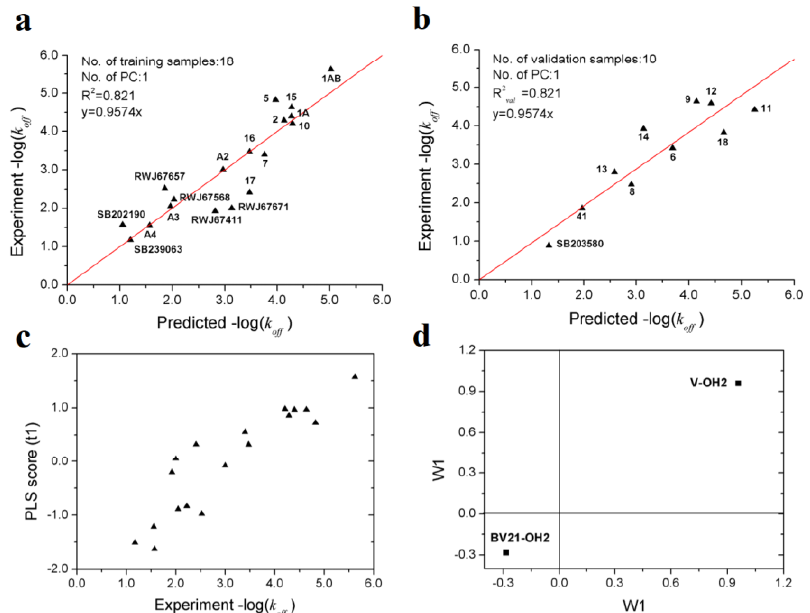
Figure 7. Optimal PLS model of the dissociation rate constants of 28 p38 MAPK inhibitors. ( a ) scatter plot of experimental vs. predicted −log( k off ) of the 18 training samples; ( b ) scatter plot of experimental vs. predicted −log( k off ) of the 10 validation samples; ( c ) first principle component scores of the 18 training samples. ( d ) weights of the two variables in the first principle component.